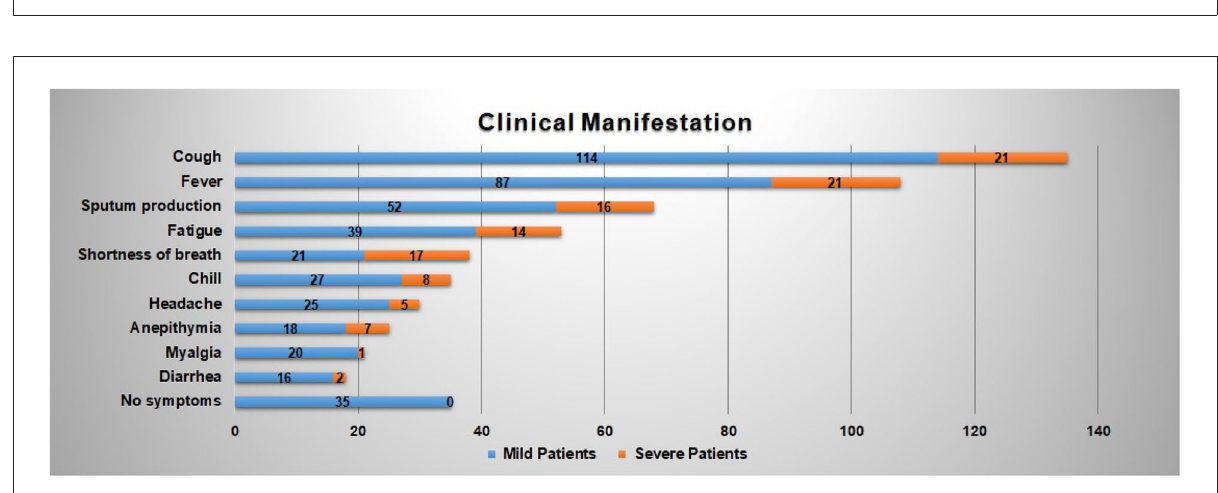
FIGURE2 Clinical manifestation of the COVID-19 patients contained in the dataset.